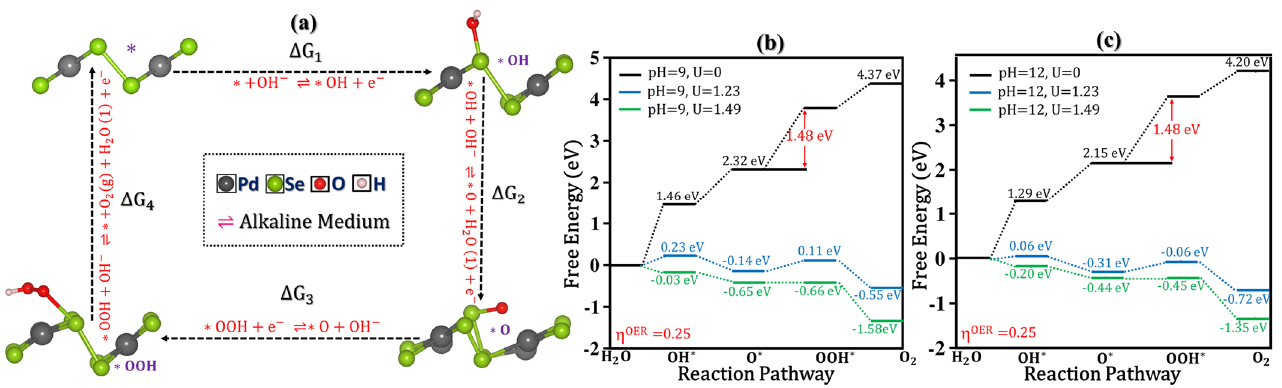
Figure 15. Proposed photocatalytic pathways and the atomic configuration of absorbed intermediates species during the ( a ) OER on the β-PdSe 2 monolayer in an alkaline medium. Free energy diagram for OER at ( b ) pH = 9 ( c ) pH = 12 on β-PdSe 2 monolayer. Reprinted with permission from ref. [105]. Copyright 2021 RSC.